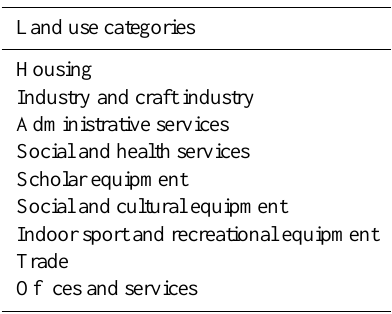
Table 1. Land use categories considered for the assessment of land use diversity.